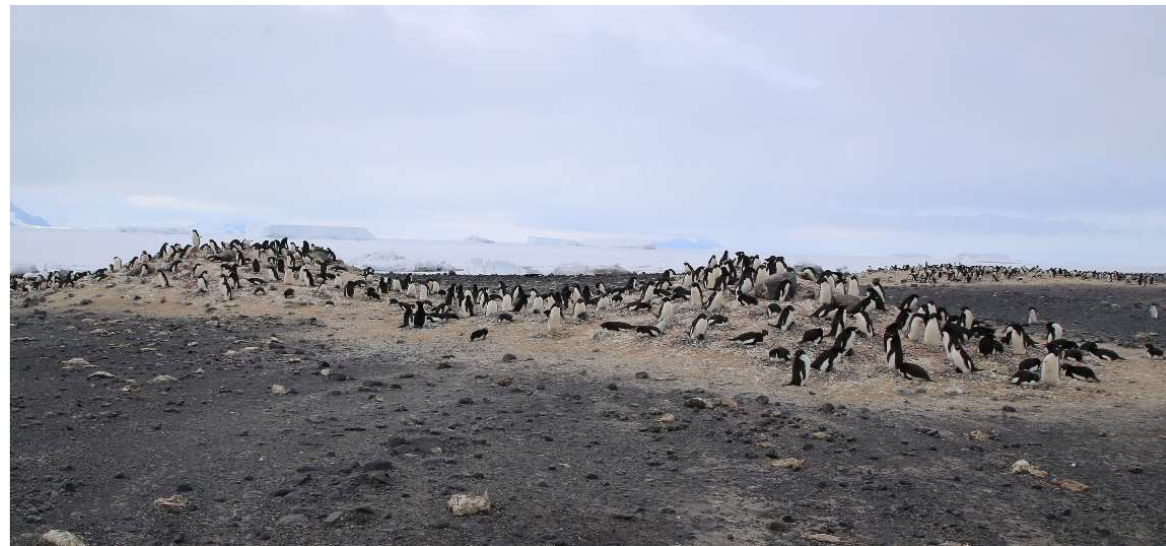
Figure 7. Artificial mounds in use by recolonized Adélie penguins at Cape Hallett. Supplementary Materials: The following supporting information can be downloaded from www.mdpi.com/xxx/s1, Figure S1: The Adelie Penguin Rookery Seabee Spit Cape Hallett Antarc- tica; Figure S2: Location of artificial mounds at Cape Hallett.